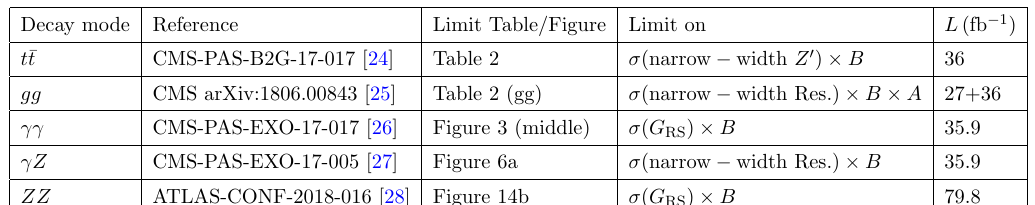
Table 2 . Constraints from resonance searches based on observed 95% CL upper limits on the resonant production cross section ( (cid:27) ) (cid:2) branching ratio ( B ) ( (cid:2) acceptance ( A )).